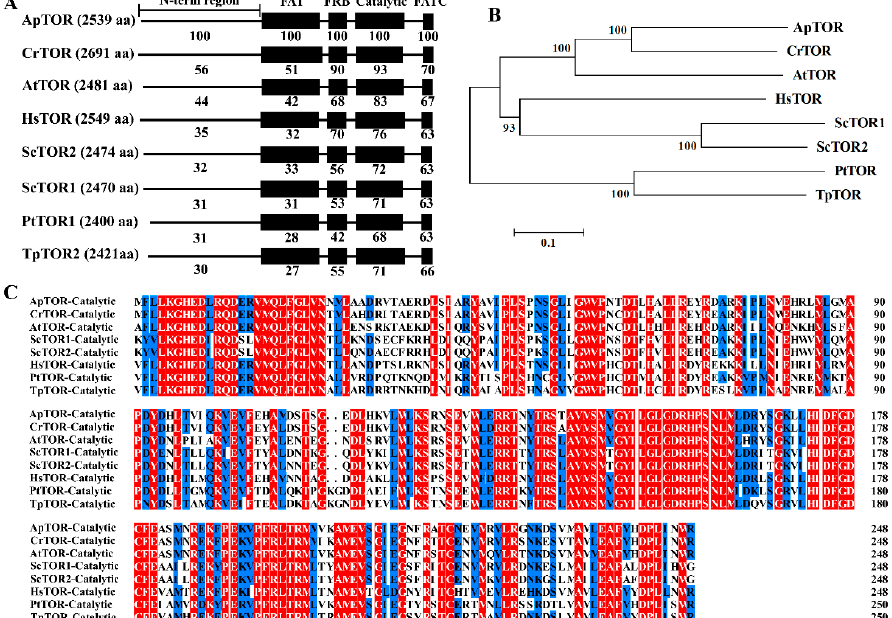
Figure 1. A structure and sequence analysis of ApTOR. ( A ) An analysis of the conserved domains of ApTOR protein and homologs from other species. The number denotes the identity (%) of ApTOR domain with homologs from other species. Chlamydomonas reinhardtii (Cr) (Chlorophyta), Arabidop- sis thaliana (At) (Plantae, Magnoliophyta), Homo sapiens (Hs) (Animalia, Chordata), Saccharomyces cerevisiae (Sc) (Fungi, Ascomycota), Phaeodactylum tricornutum (Pt) (Bacillariophyta), Thalassiosira pseudonana (Tp) (Bacillariophyta). ( B ) The phylogenetic tree of ApTOR protein and homologs from other species. The phylogenetic tree was constructed by MEGA 4 software using the Neighbor-Joining method. Numbers represent bootstrap percentages (1000 of bootstrap replicates). ( C ) Sequence align- ment of the catalytic domains of ApTOR protein and homologs from other species. Red represents identical amino acid sequences, and blue represents more than 75% identical amino acid